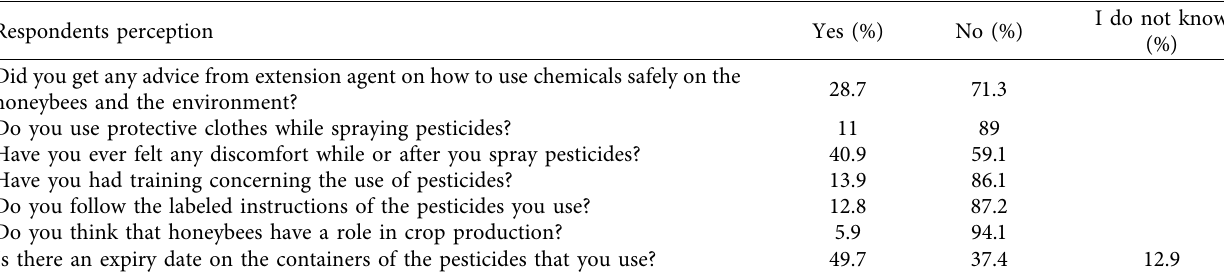
100 Table 10: Farmers’ awareness on pesticides application